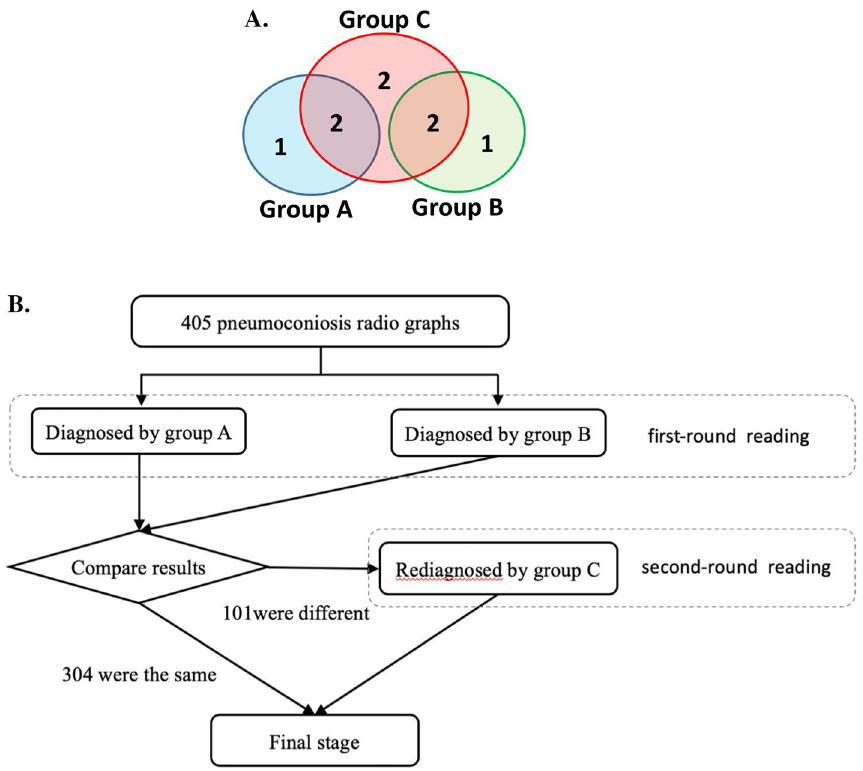
Figure 1. Annotation scheme. ( A ) Group assignment for radiologists. ( B ) The procedure of labelling chest radiographs in the training dataset.